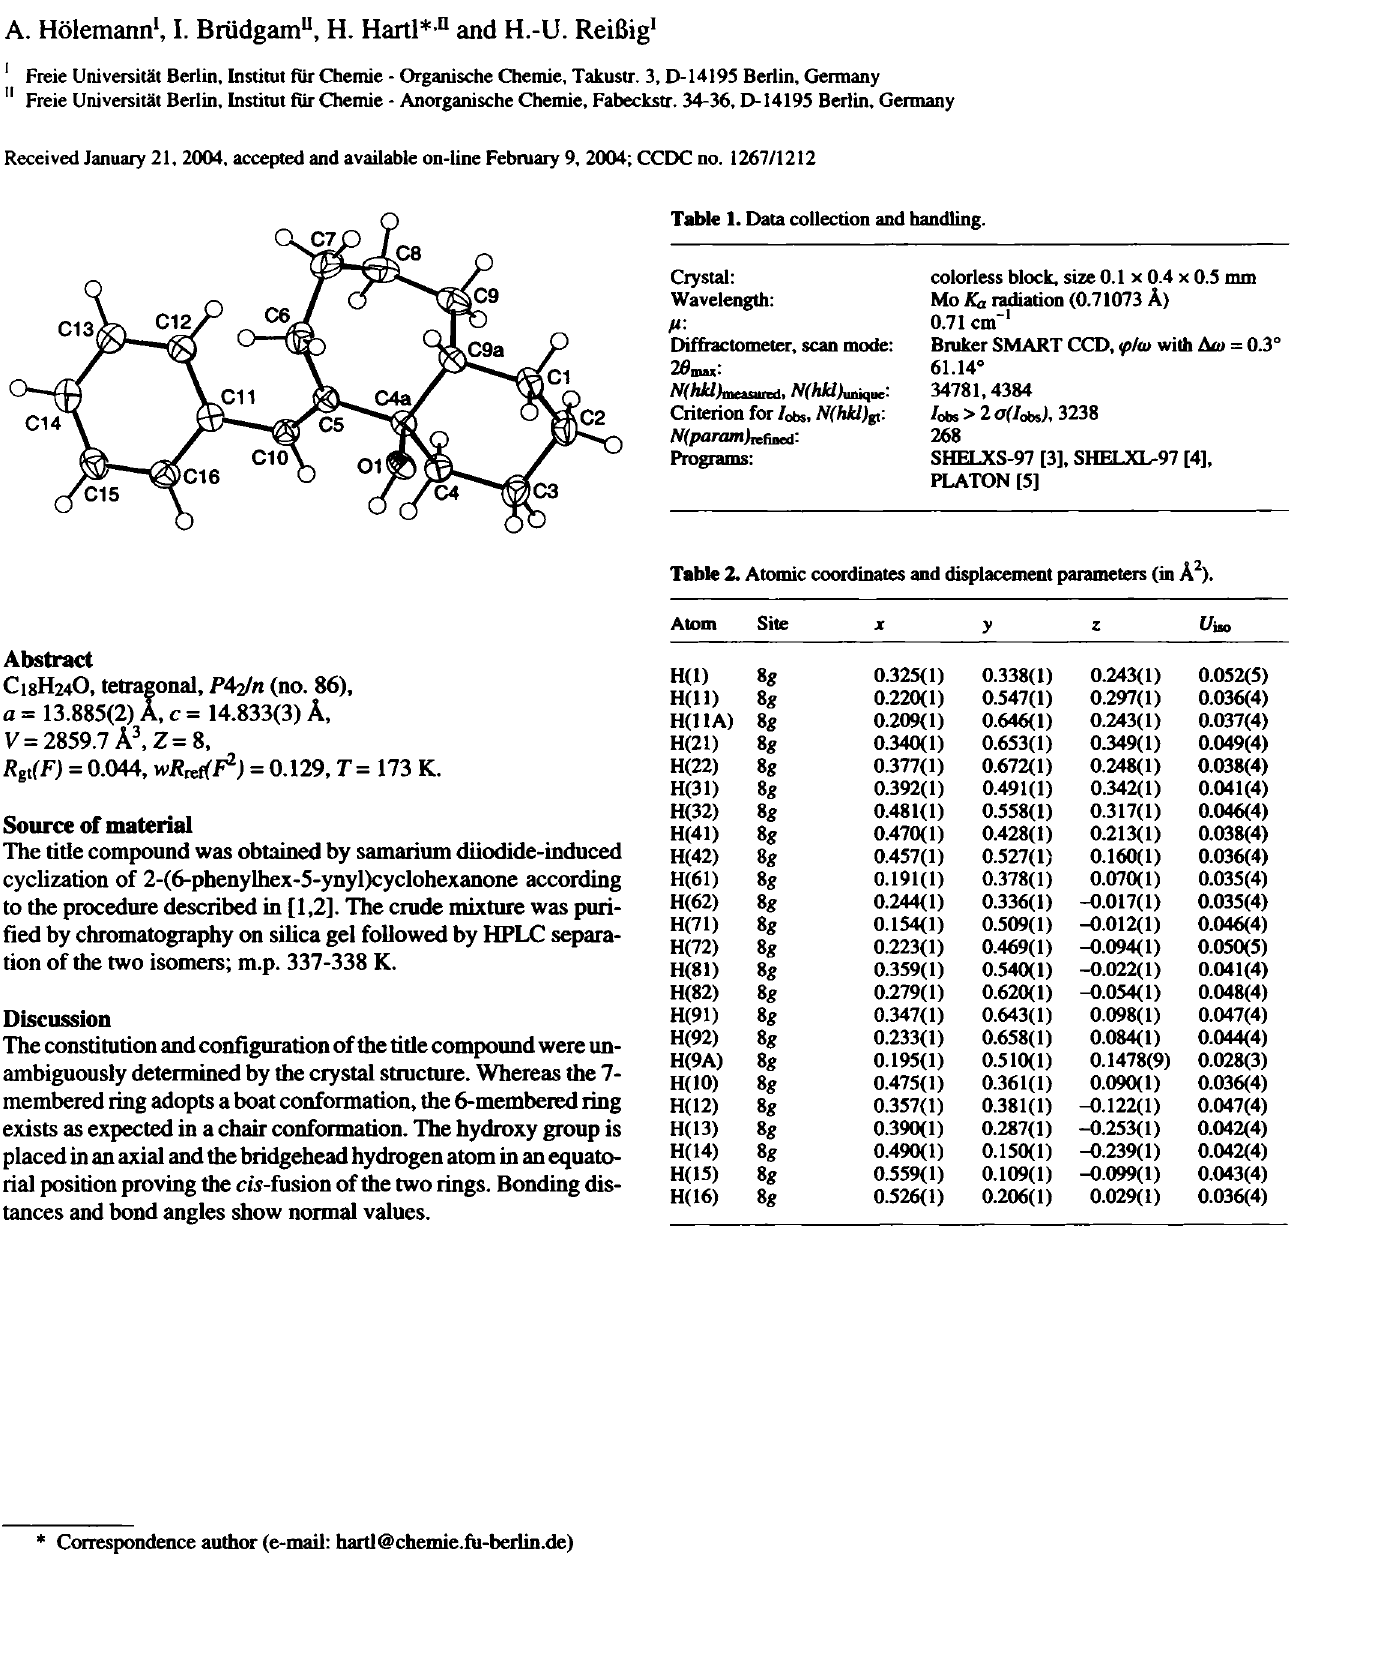
Table 1. Data collection and handling.